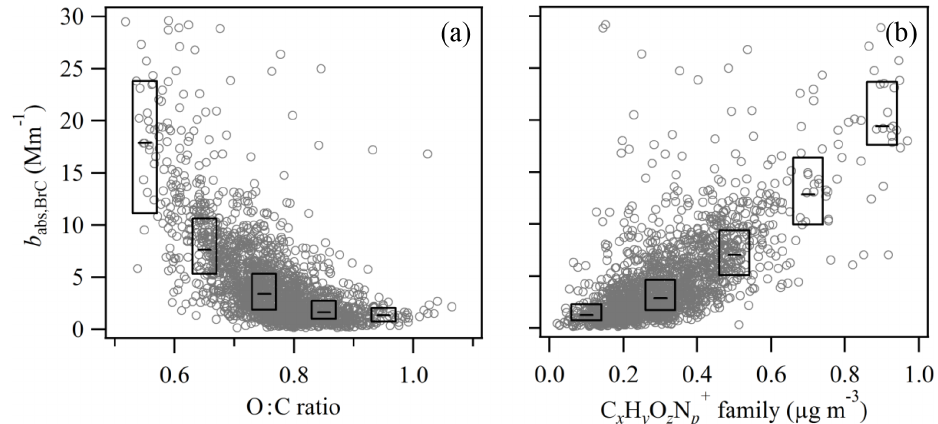
Figure 12. Relationships between the BrC absorption coefficient and the organic PM 1 composition. Scatter plots of b abs , BrC against (a) the O : C ratio and (b) the mass concentration of the nitrogen-containing C x H y O z N + p family. For the C x H y O z N + p family, all ions contain at least one C atom and one N atom, meaning x > 0, y ≥ 0, z ≥ 0, and p > 0. Boxes indicate interquartile ranges, and horizontal lines within the boxes indicate medians. For panel (a) , each bin width is 0.1, from 0.5 to 1.0, and for panel (b) , each bin width is 0.2, from 0 to 1.0. In complement, Fig. S14 shows the relationships between the BrC absorption coefficient and the fractional contributions of the C x H y O + z and C x H y O z N + p families to organic PM 1 . Table 2. Relationship of PMF factors to organonitrogen characteristics. Listed for each factor are the mean loading of the time series, the percent contribution of the C x H y O z N + p family to the factor profile, and the mean mass concentration of the C x H y O z N + p family (based on multiplication of columns 2 and 3), as well as the Pearson R correlation of factor loading against the mass concentration of C x H y O z N + p , the mass concentration of organic nitrates, and b abs , BrC . The C x H y O z N + p family corresponds to the sum of all ions containing at least one C atom and one N atom, as measured by the AMS. Detailed family-colored spectra showing the nitrogen-containing ions for all PMF factors are presented in Fig. S6, and the most important ion fits are shown in Fig. S7. The AMS method characterizes organic nitrates through the NO + and NO + fragments, which remain distinct from the larger fragments of the C x H y O z N + p family (Sect. S1 and discussion therein). 2 PMF Mean factor loading Nitrogen characteristics of Pearson R of factor loading factor (µgm − 3 ) factor profile C x H y O z N + p family Mass concentration Against the mass Against the mass Against contribution of the C x H y O z N + p concentration of concentration of b abs , BrC (%) family (µgm − 3 ) C x H y O z N + p family organic nitrates